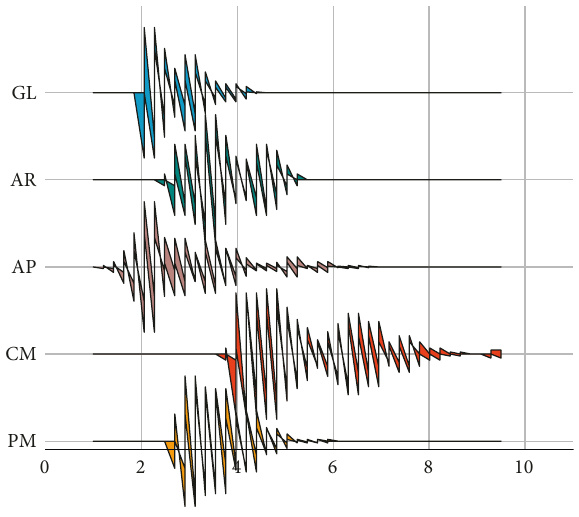
Figure 2: The curve distribution of VaRin different accounting